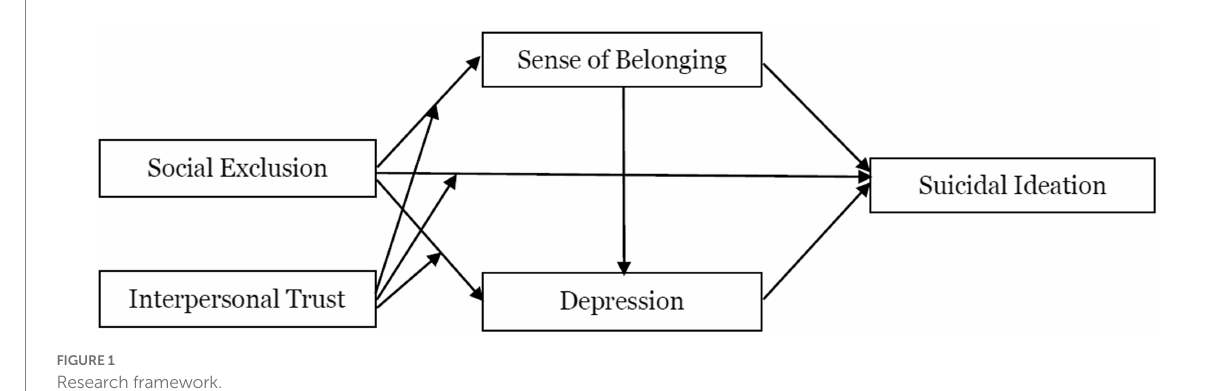
FIGURE 1 Research